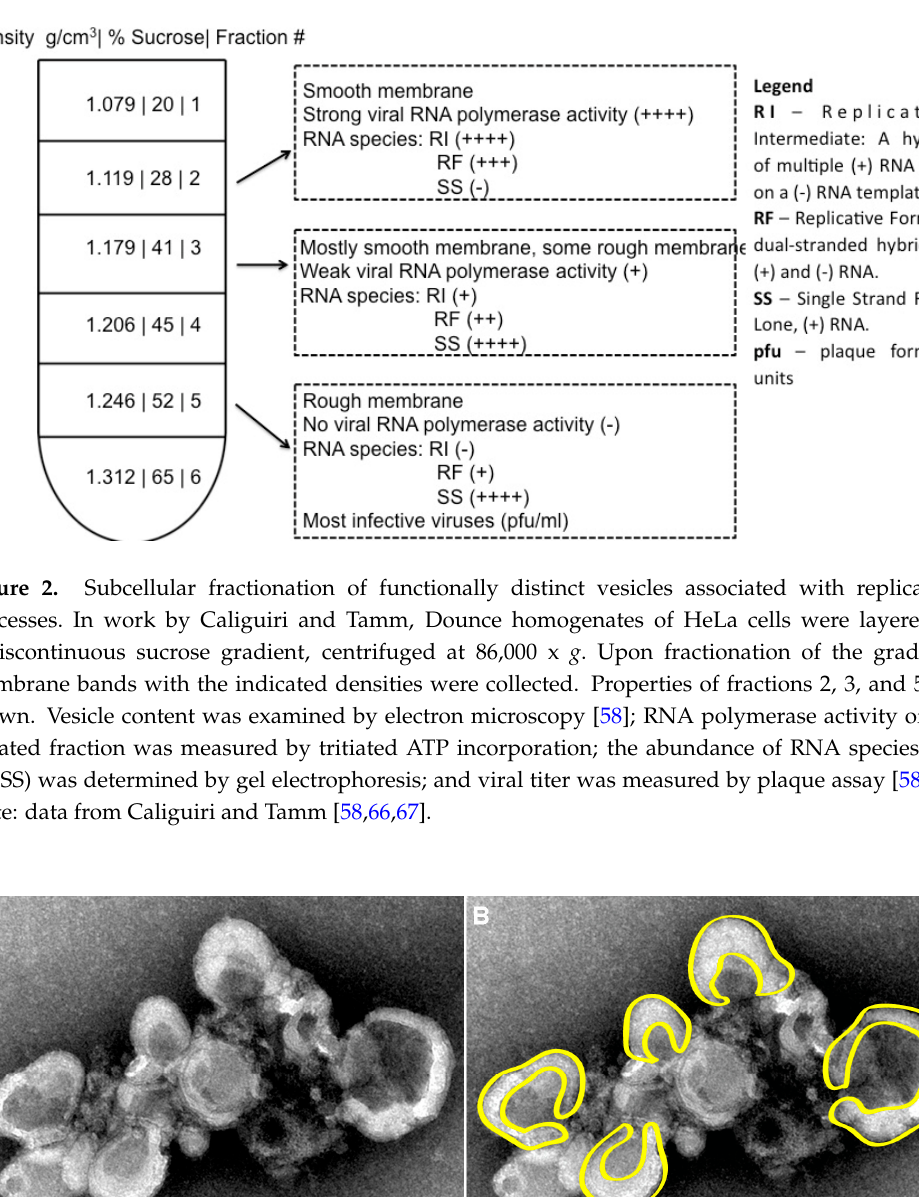
Figure 3. Morphology of rosette isolated from poliovirus ‐ infected cells . ( A ) U body ‐ like densities surround a dense central region of smaller vesicles. Cell fractionated material was prepared and imaged by Evan Rossignol using methods from Schlegel et al. , 1996 [54]. Sample from 4 hpi is negatively stained and imaged by electron microscopy; ( B ) Cartoon highlights the horseshoe ‐ shaped (U body ‐ like) configurations of individual vesicles of the cluster. Magnification bar, 100 nm.